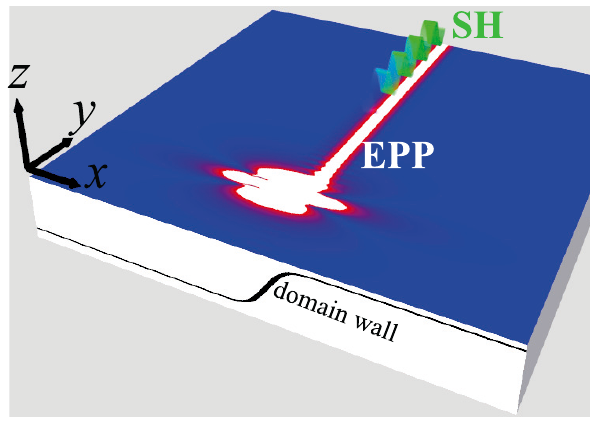
Figure 1: Scheme of the second-harmonic generation (SHG) by the chiral current in magnetic TI. A point dipole excited an edge plasmon-polariton (EPP) localized at the domain wall. Nonlinear conductivity results in the emergence of the SH signal, which is also localized at the domain wall. TI, topological